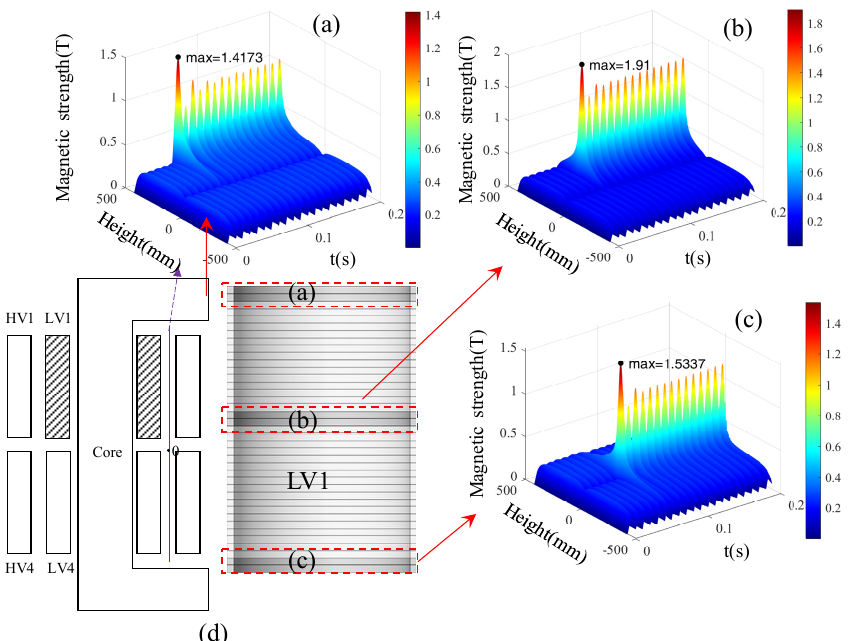
Figure 3. The positions of TTFs and the distribution of magnetic flux leakage between HV1 and LV1. ( a ) Top turn-to-turn fault. ( b ) Middle turn-to-turn fault. ( c ) Bottom turn-to-turn fault. ( d ) The positions of three cases of TTF.